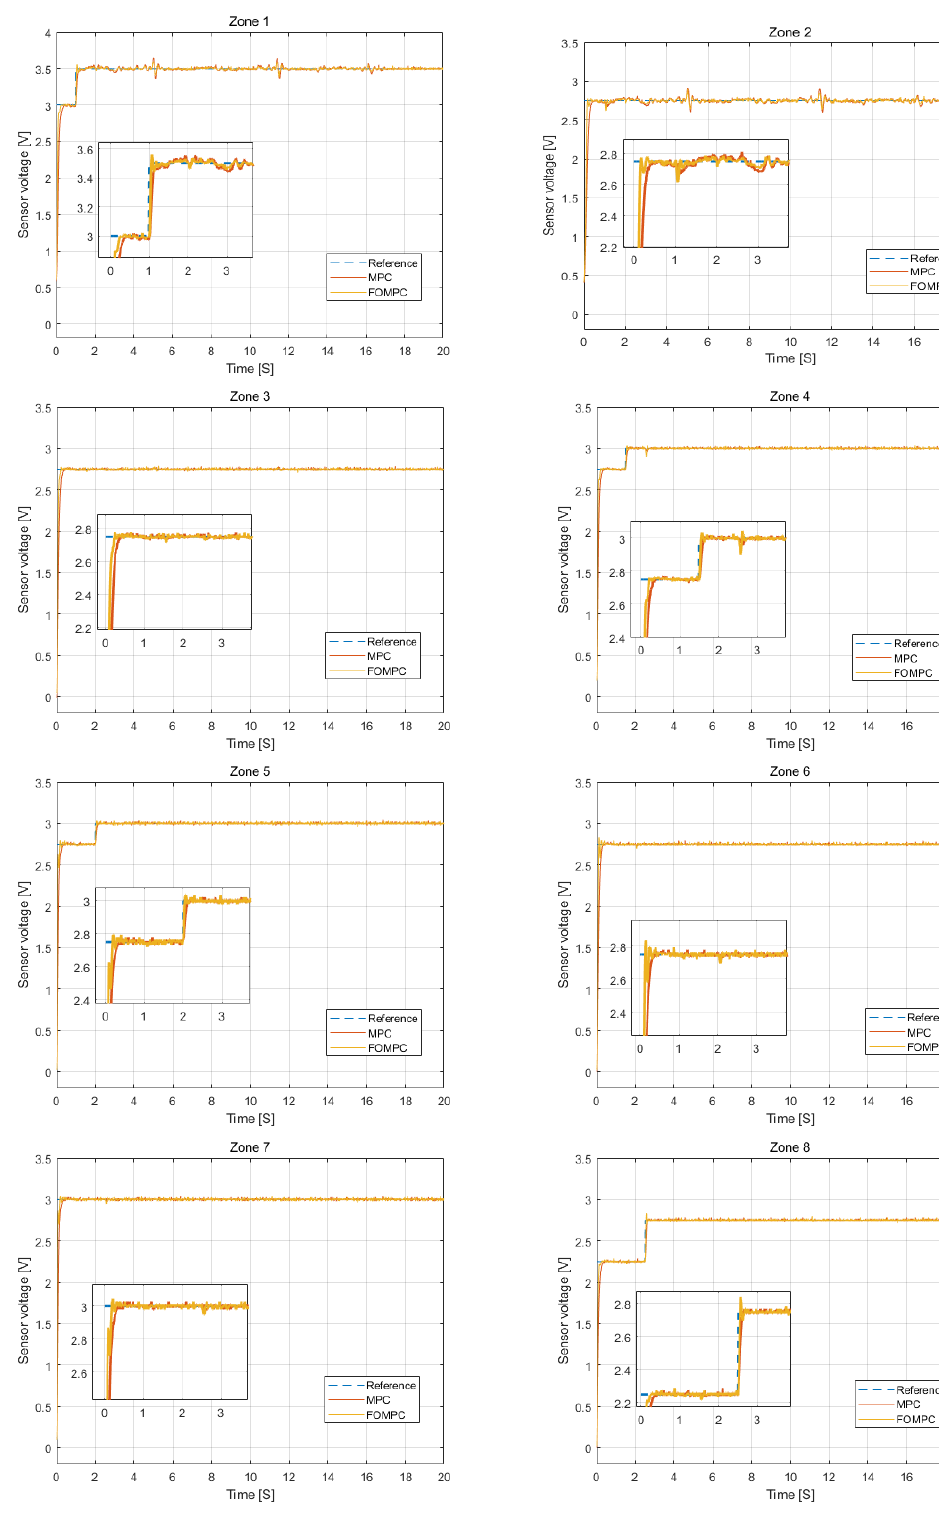
Table 4. Indices for IARE in the reference tracking experiment based on multiple lighting control.